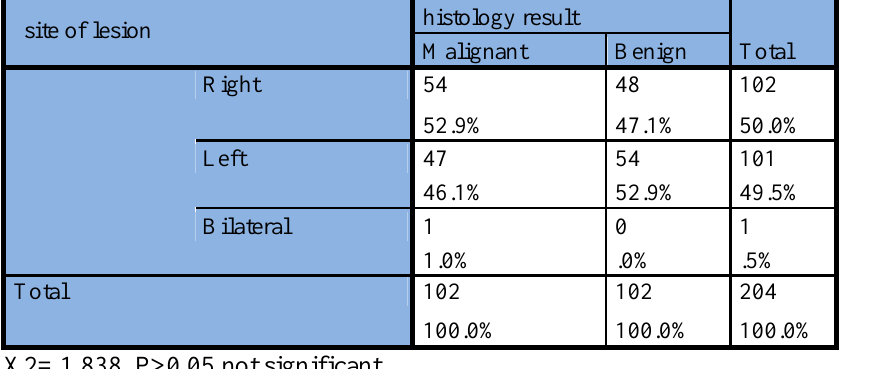
Table 5 The distribution of the breast lesion according to the site site of